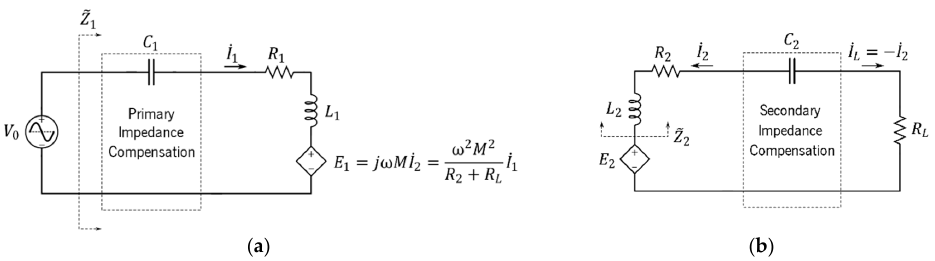
Figure 11. Impedance compensation networks in: ( a ) primary circuit; ( b ) secondary circuit.